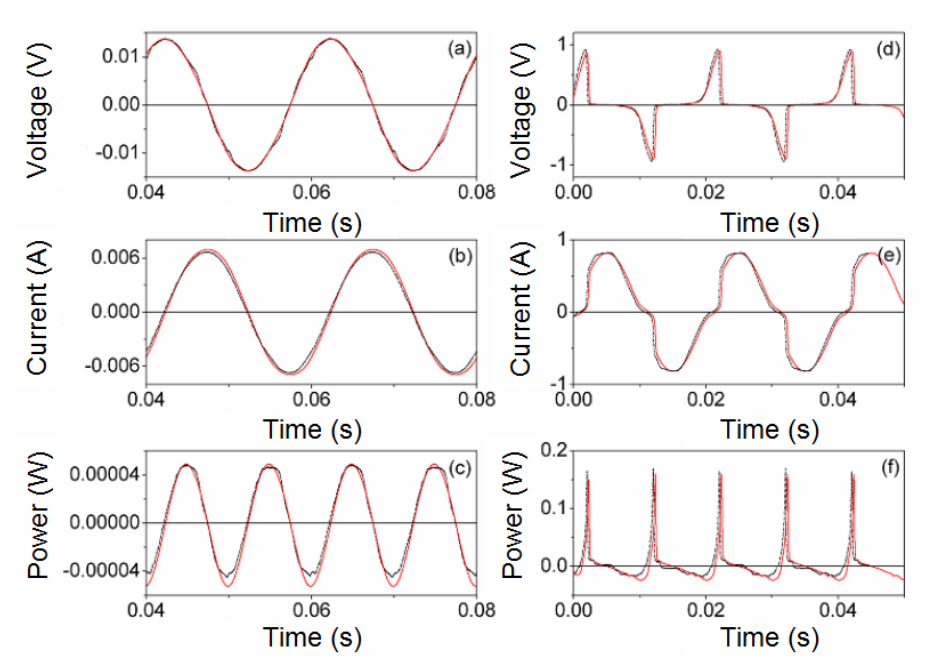
Figure 4. Experimental (-  -  -) and simulated waveforms at 50 Hz (  ) . ( a – c ) V